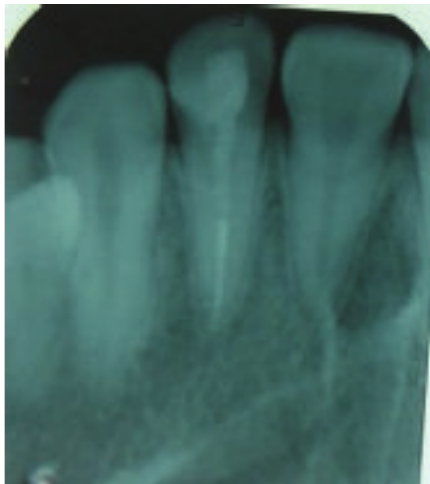
Figure 6: Single visit root canal treatment done and fragment reattached using fiber post and dual cure resin cement.